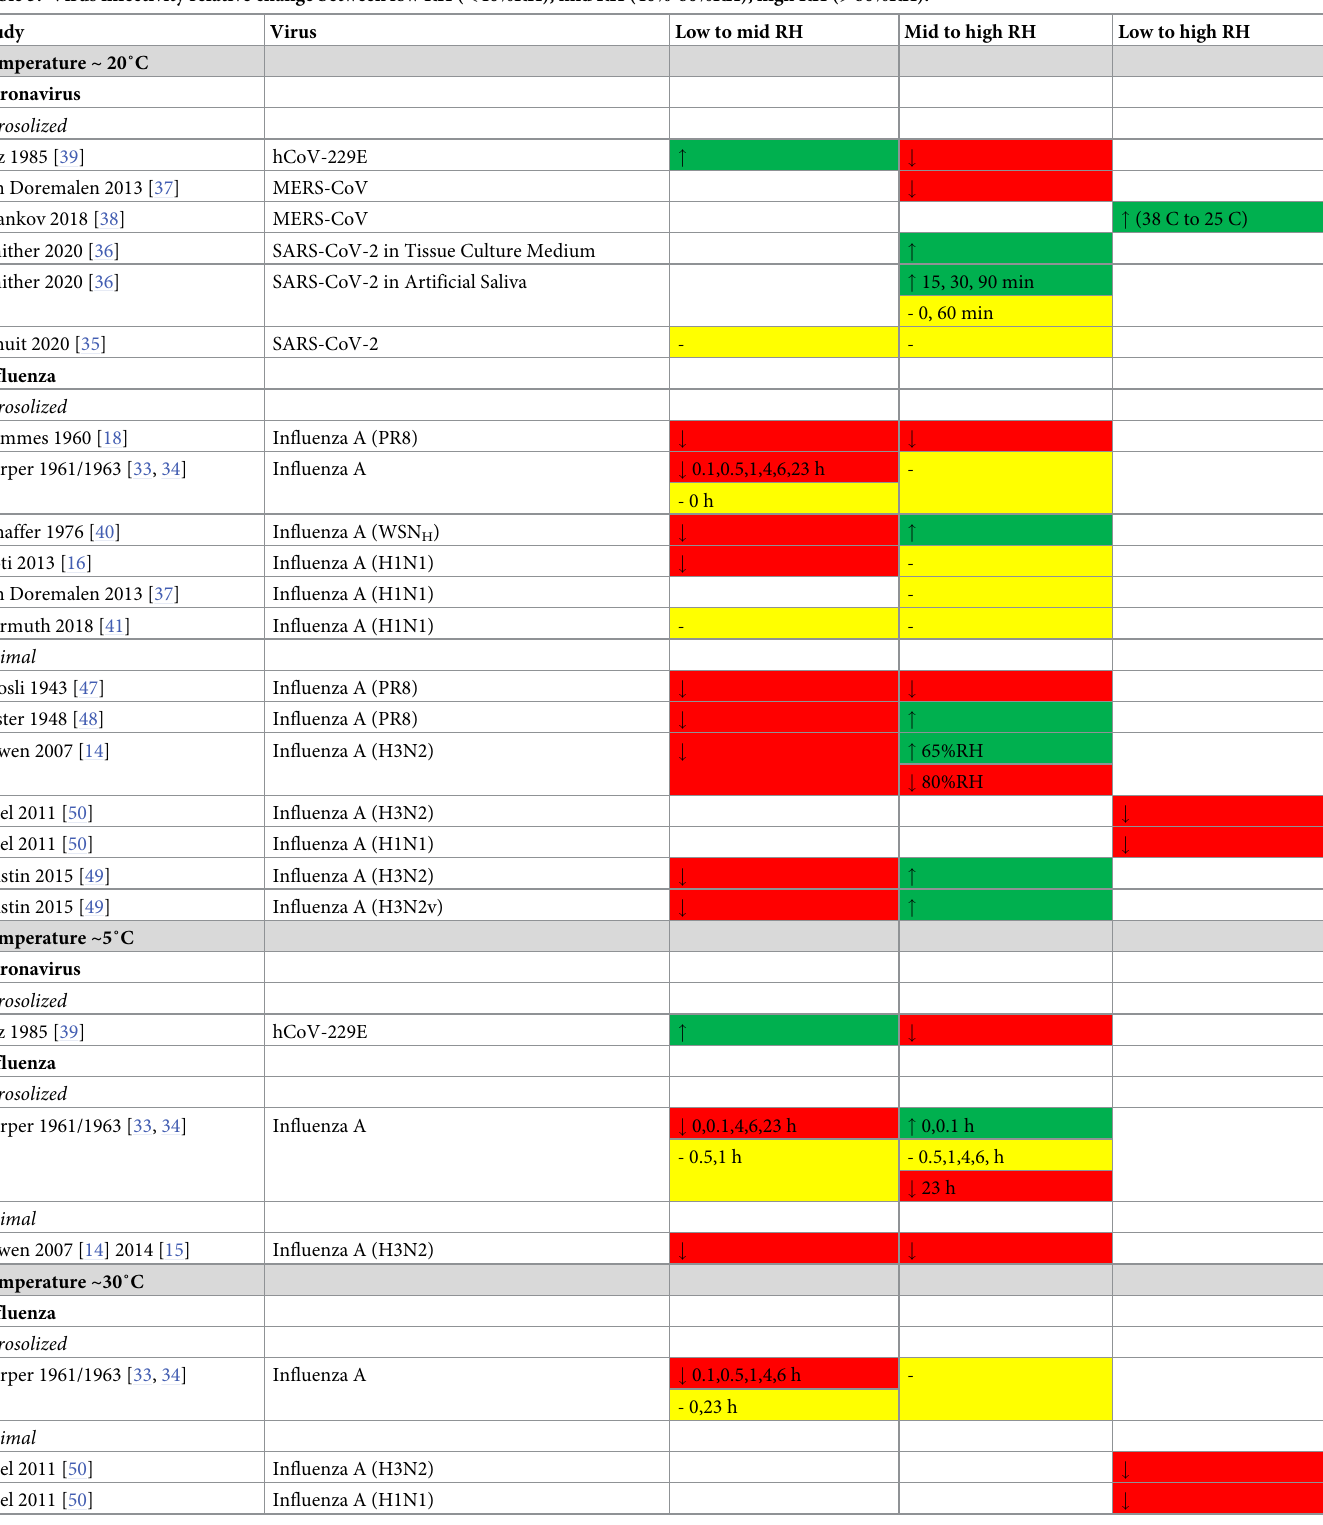
Table 5. Virus infectivity relative change between low RH ( < 40%RH), mid RH (40%-60%RH), high RH ( >